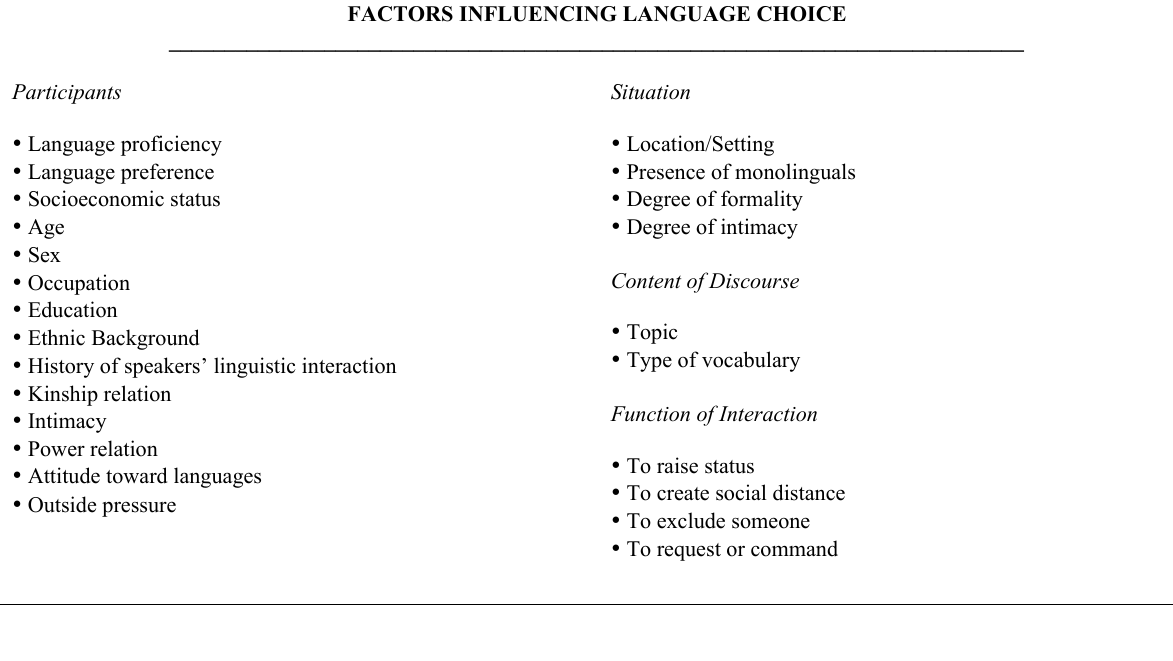
Grosjean’s (1982, p. 136) List on Factors Influencing Language